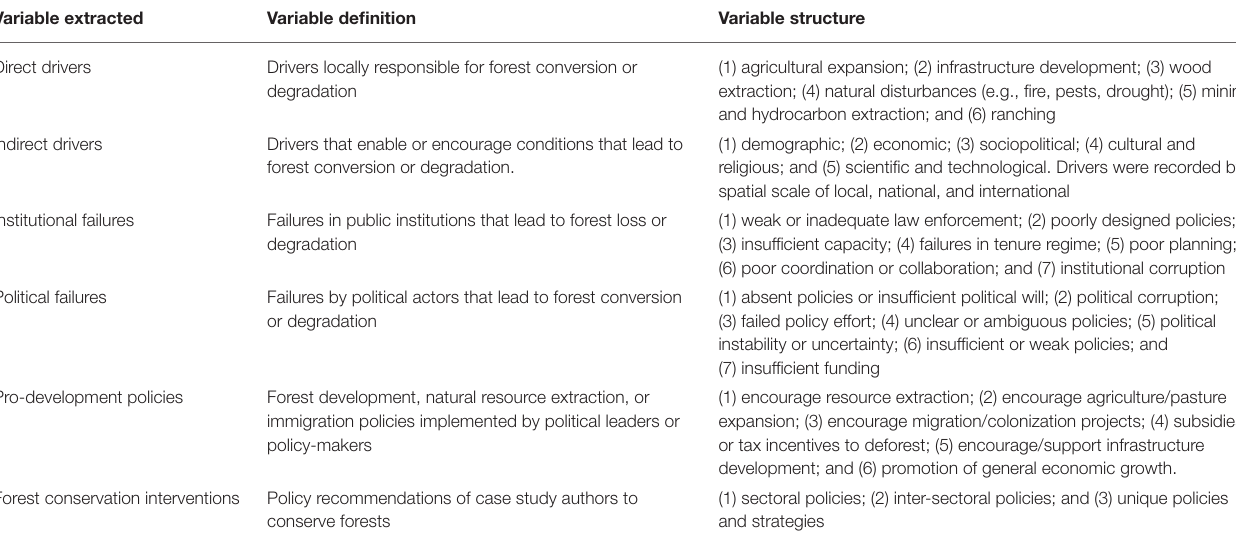
TABLE 1 | The drivers of IF loss and the proposed conservation interventions extracted from the case studies. Variable